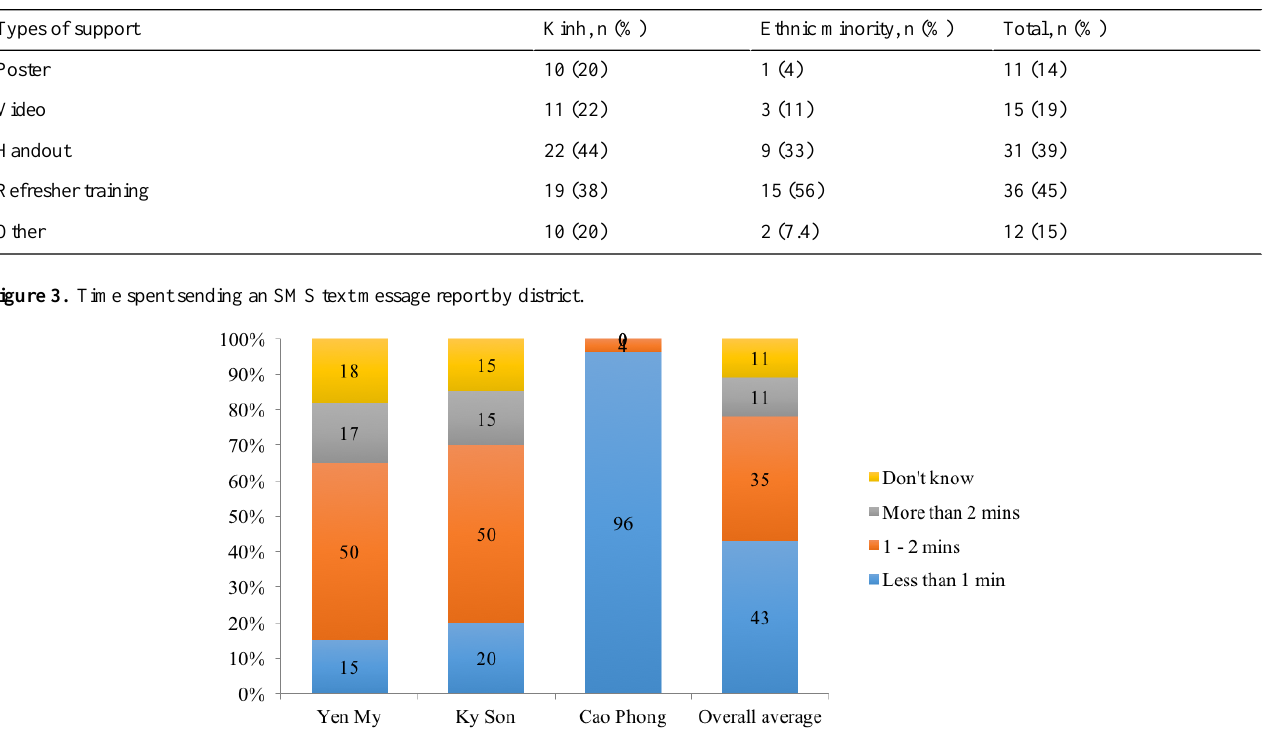
Table 5. Types of support requested by the participants.